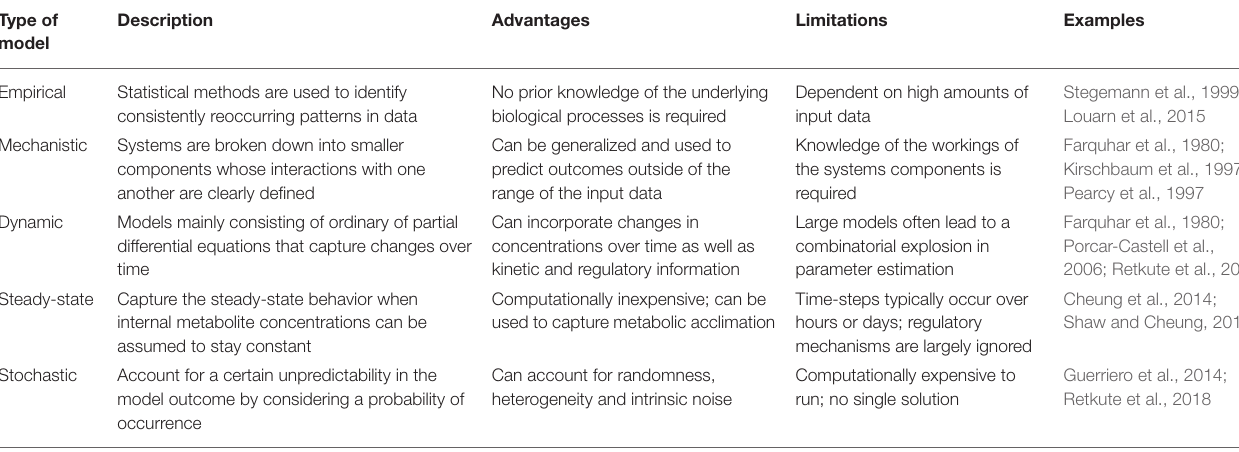
TABLE 1 | A brief overview of the primary types of models applied to study photosynthetic responses to fluctuating